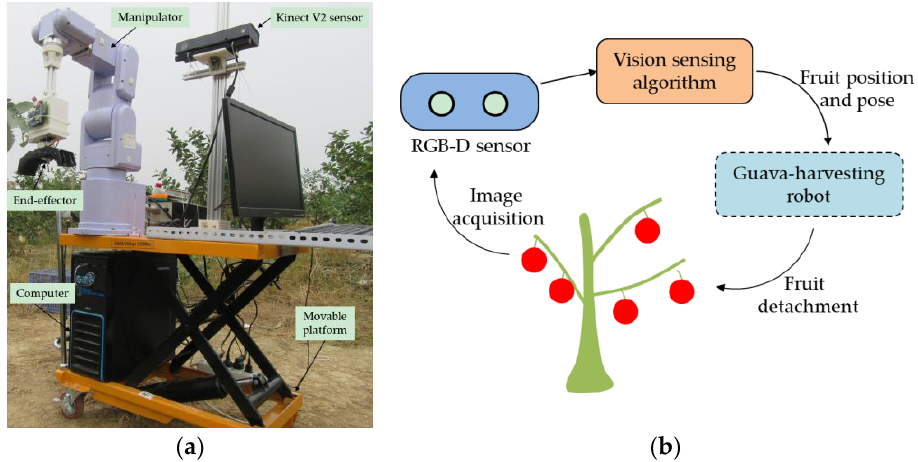
Figure 1. The guava-harvesting robot and its vision sensing system. ( a ) Robot system; ( b ) vision sensing system.